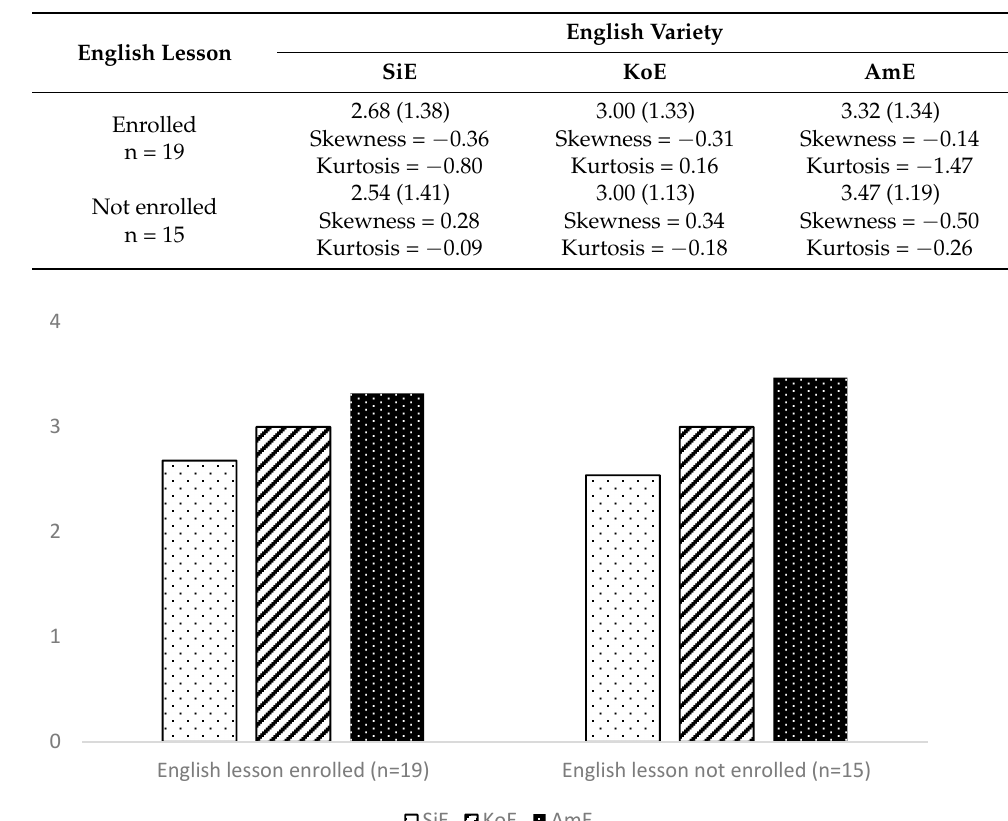
Figure 2. Mean score of ratings for SiE, KoE, and AmE of two groups: 5-year-old Korean children enrolled in English lessons ( left ) and not enrolled ( right ).